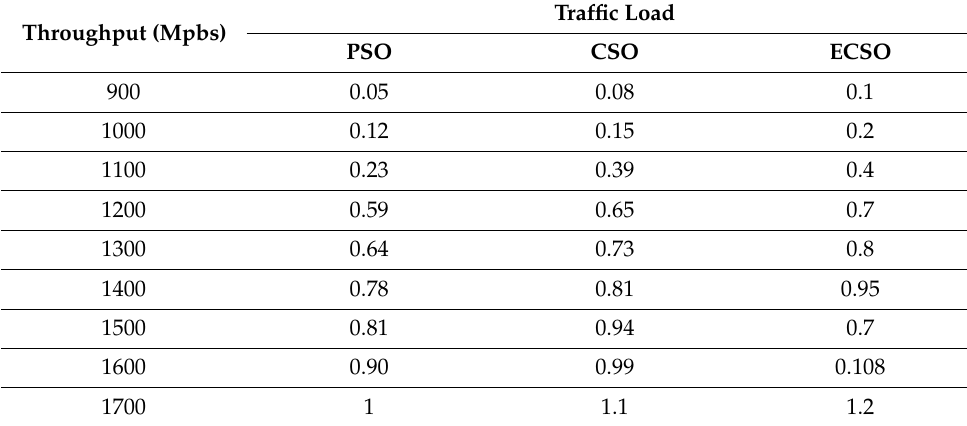
Figure 6. Traffic load against throughput.